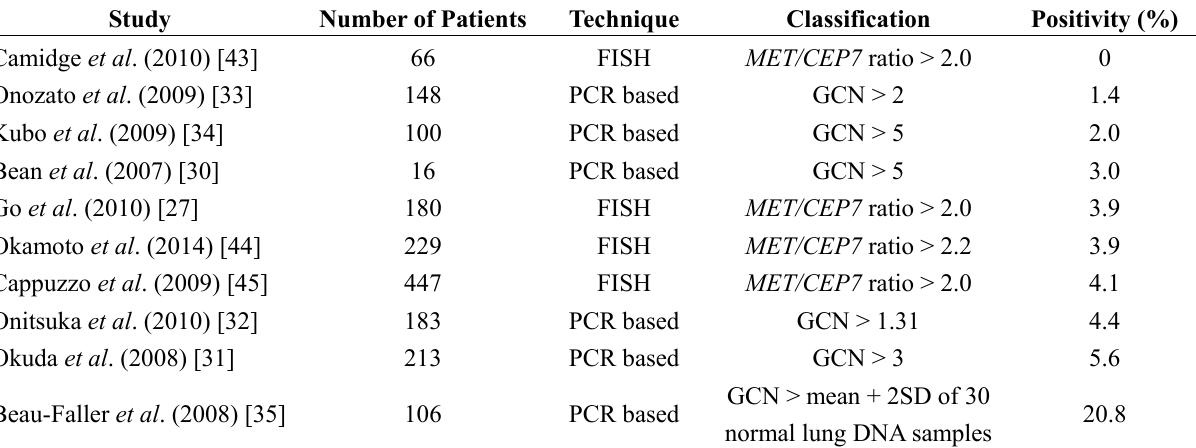
Table 1. Prevalence of MET amplification and increased MET gene copy number (GCN) in NSCLC.